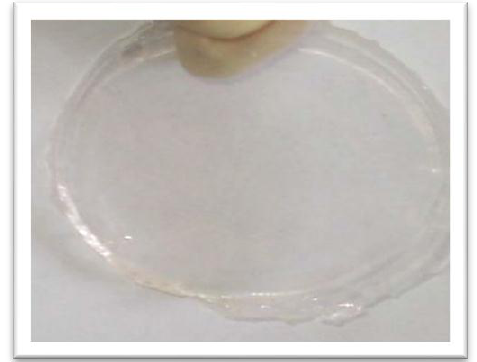
Figure 3: Formula F1 containing